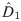
ABIDE data set: Distance contrast D^1 between the weighted ASD and control connectomes for a threshold T = 0.8.